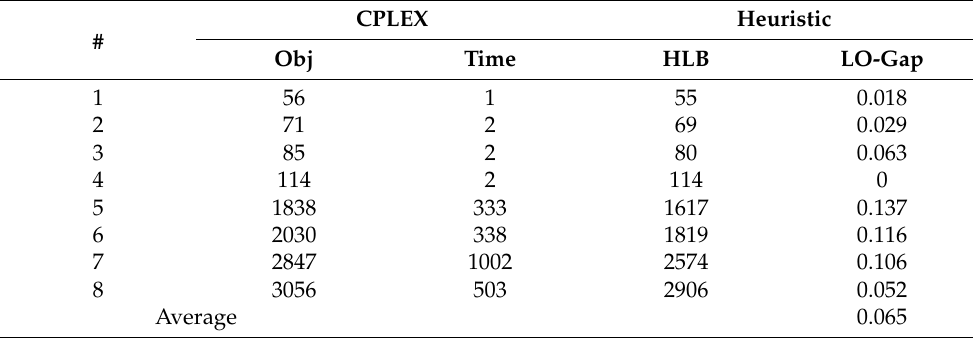
Table 6. Computational results to compare CPLEX and the heuristic method.